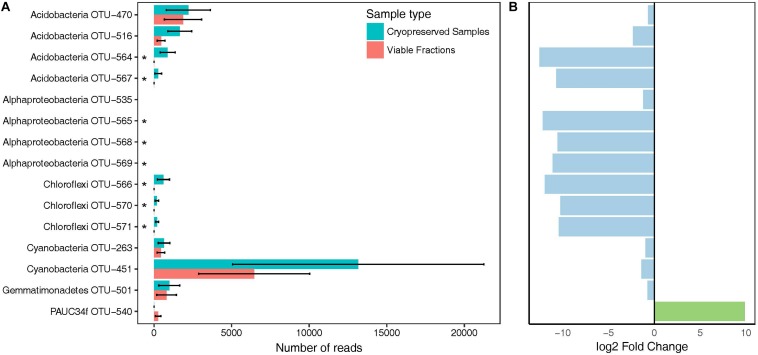
Bacterial taxa showing differences in abundance in viable fractions (PMA Treatment) as detected by DESeq2. (A) Total read counts of significantly different (padj < 0.01) taxa from duplicate cryopreserved (turquoise) and viable (red) fractions (PMA Treatment). Asterisks mark taxa falling below the detection threshold of 0.1% relative abundance in the viable fractions. (B) Log2 fold change of OTUs that increased (green) or decreased (blue) in viable fractions compared to cryopreserved samples. Bars correspond to the OTU names in A).